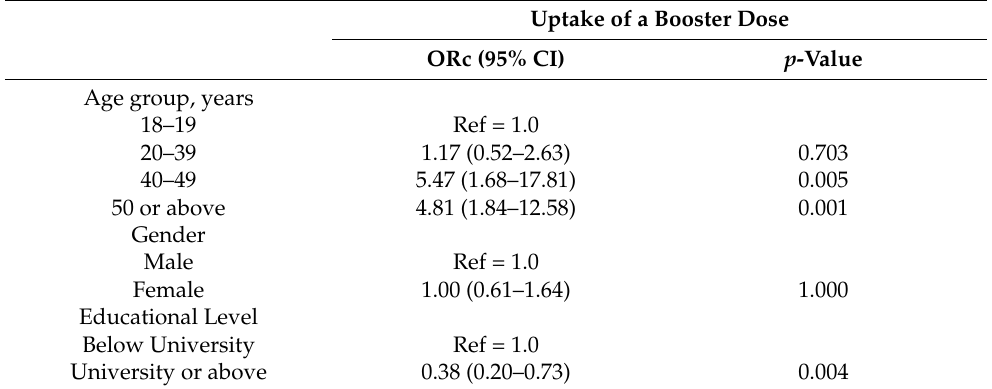
Table 2. Associations between background characteristics and COVID-19 vaccine booster dose uptake ( n =